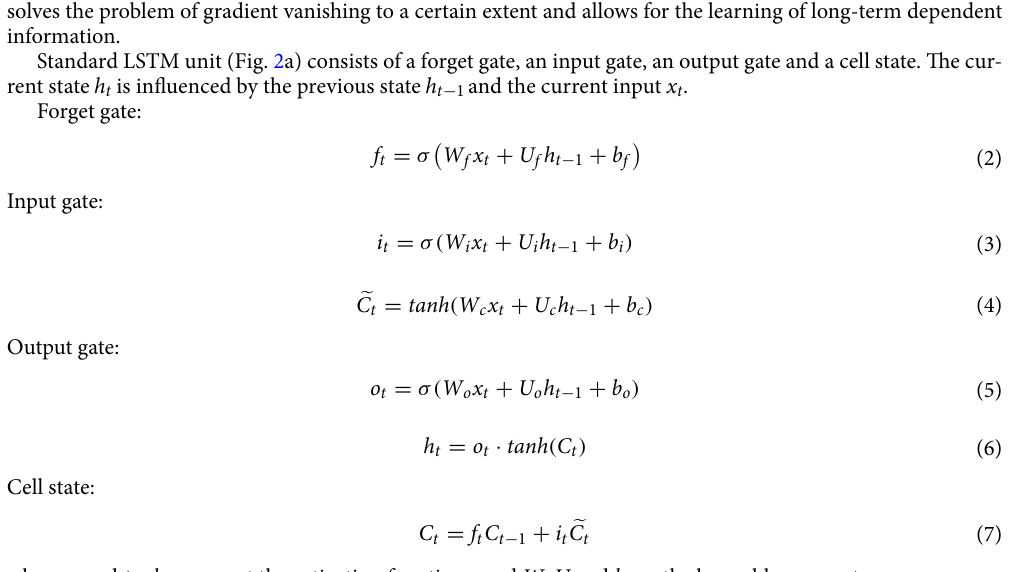
which is a variant of RNN, combining short-term memory with long-term memory through gate control. LSTM solves the problem of gradient vanishing to a certain extent and allows for the learning of long-term dependent